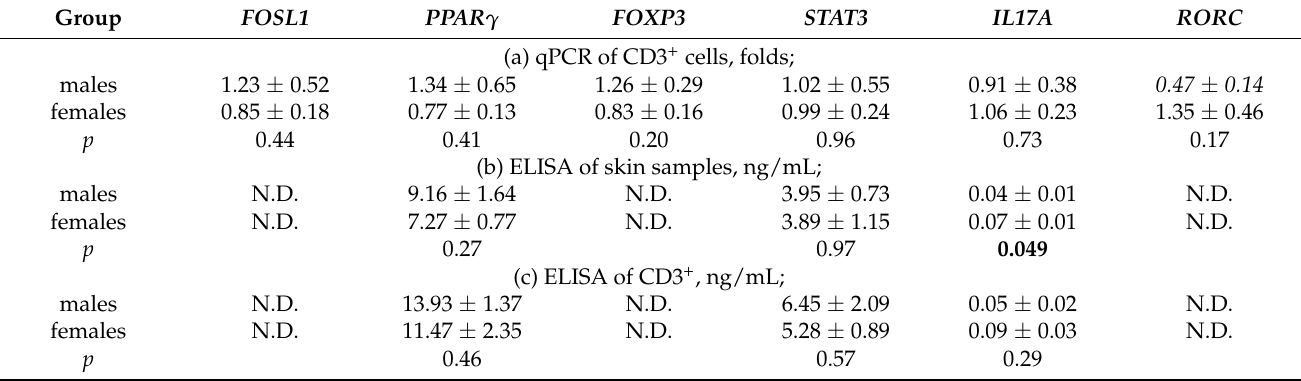
Table 4. Comparative analysis of gene and protein expression in healthy male ( n = 4) and female ( n = 6) volunteers.